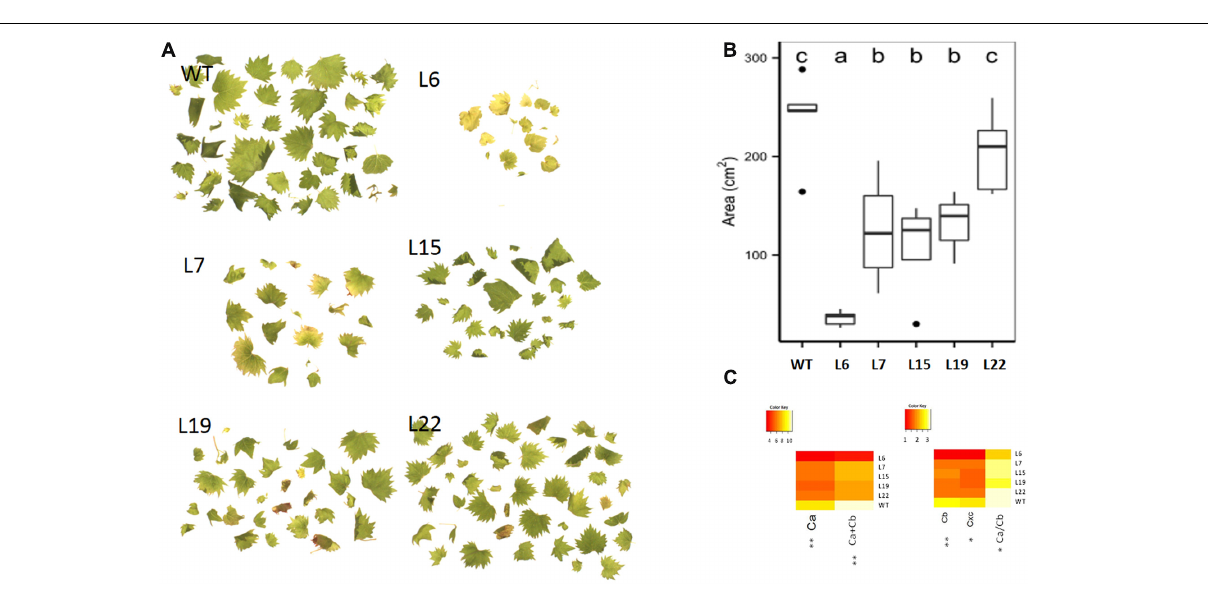
FIGURE 3 | Leaf area and color. (A) Leaves morphology, (B) leaves total area measured in cm 2 . (C) Heatmap representation for chlorophylls and total carotenoids. ( ∗ ) and ( ∗∗ ) respectively indicates significant differences ( p < 0.05), and highly significant differences ( p < 0.01). A legend with the color scale is reported on the top left part of each